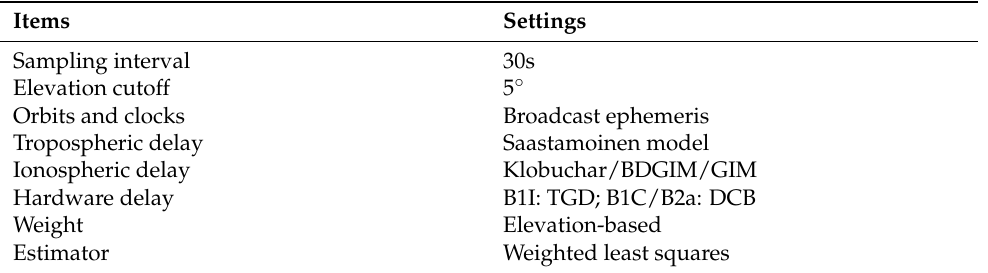
Table 3. The data processing strategies of single-frequency